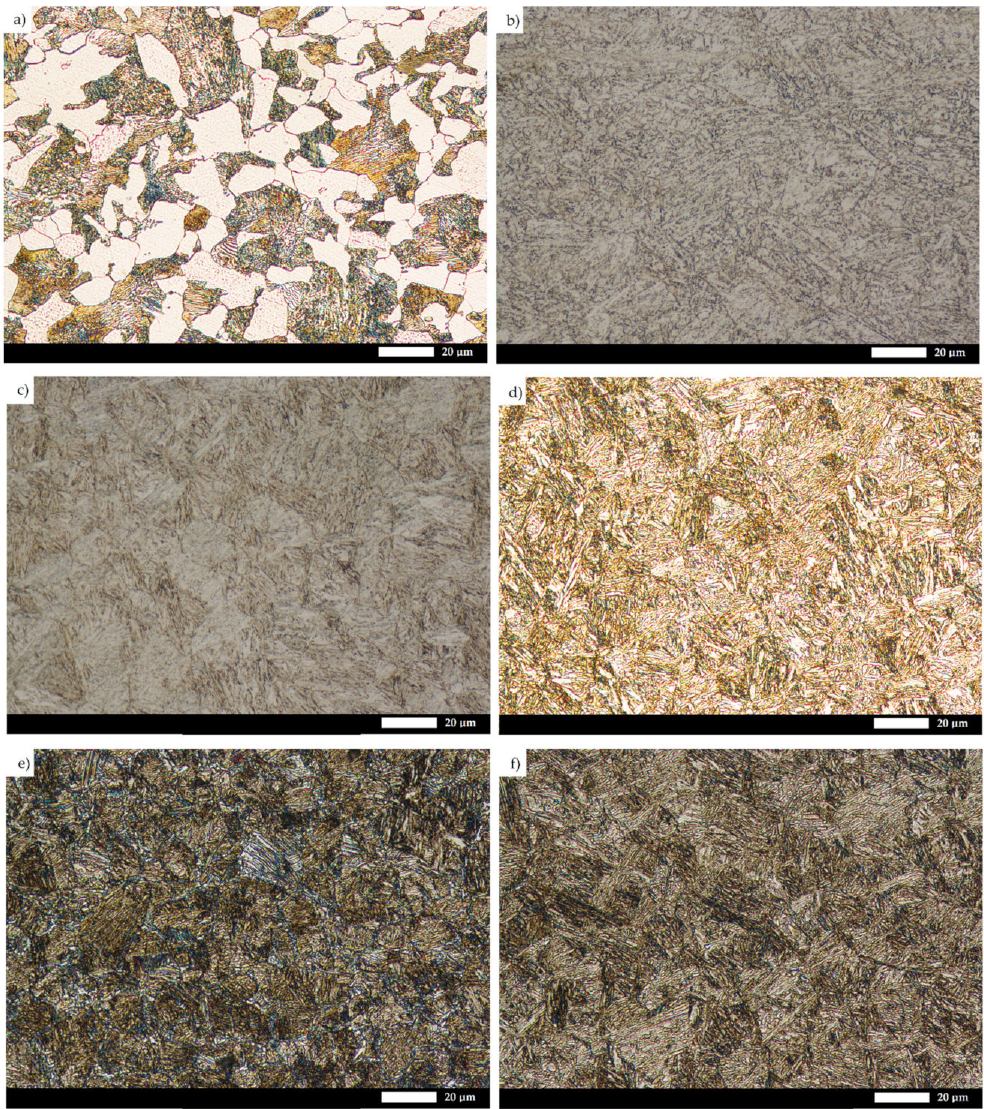
Figure 4. Microstructure of the tested types of steels: ( a ) 38GSA (N); ( b ) Creusabro 4800; ( c ) Creusabro 8000; ( d ) TBL PLUS; ( e ) XAR 600; ( f ) 38GSA (HT). Light microscopy, 500 × , etched with 5% HNO 3